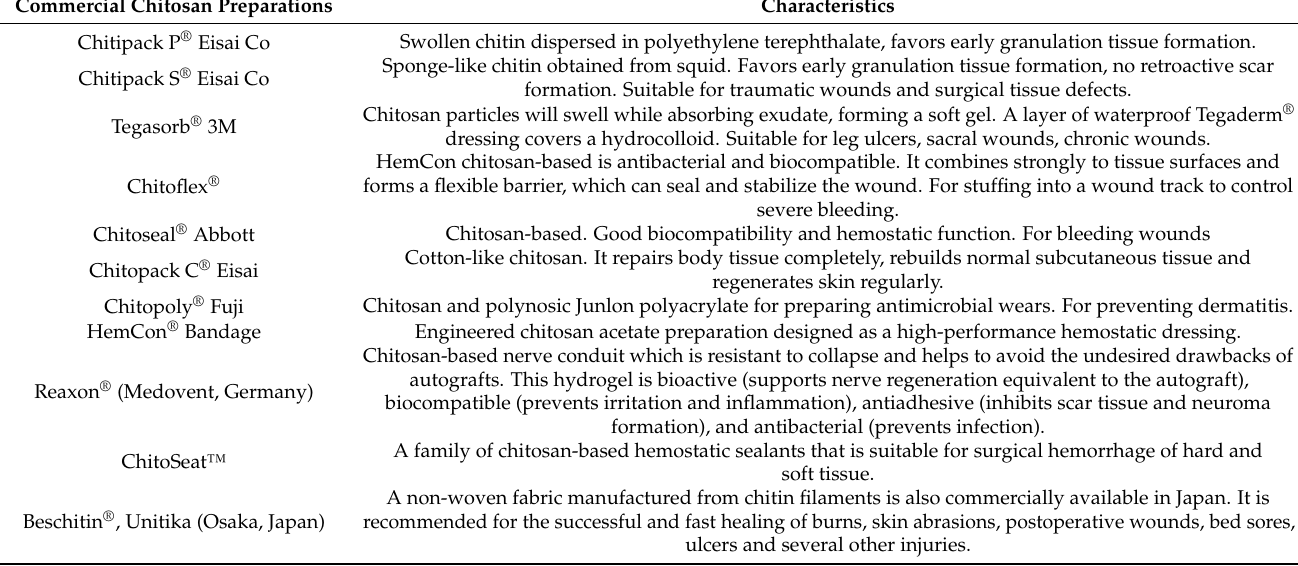
Table 4. Commercial chitosan preparations and their characteristics reviewed in references [14,18,114]. Commercial Chitosan Preparations